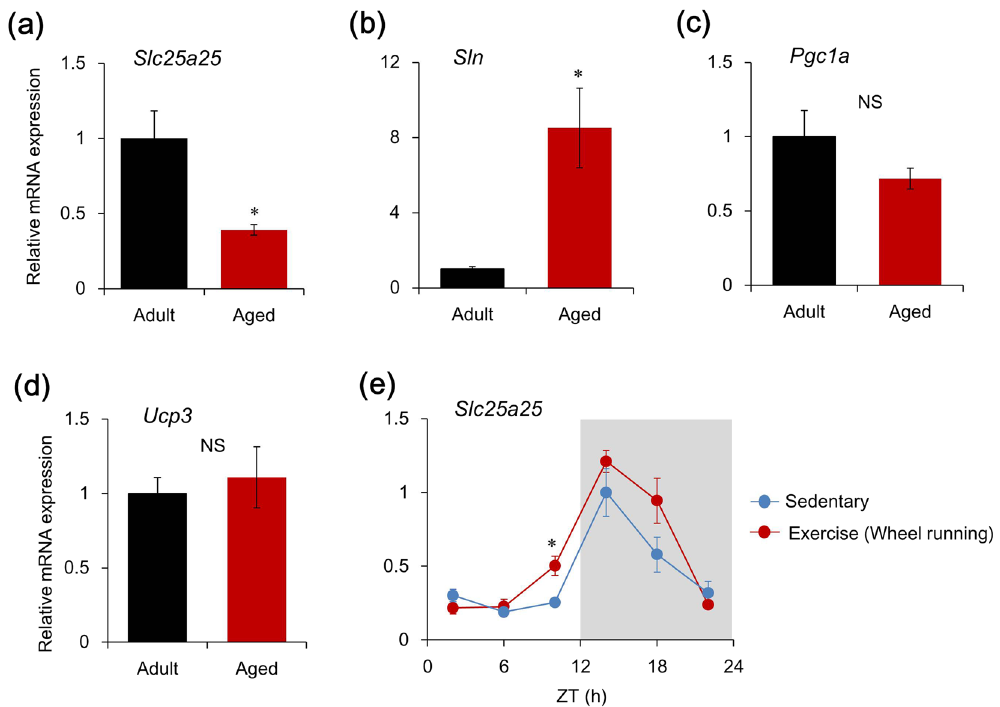
Figure 6. Aging gene-dependently affects thermogenic gene expression. ( a – d ) Messenger RNA expression of thermogenic gene in skeletal muscles of adult and aged mice (aged 7–8 and 23–24 months, respectively). Data are expressed as means ± SEM (n = 6–10 per group). Maximal value for adult mice is expressed as 1.0. * P < 0.05 for adult vs. aged mice. ( e ) Effects of voluntary running on Slc25a25 mRNA expression in skeletal muscle. Mice were individually housed in cages with or without (to mimic sedentary conditions) running-wheels for four weeks. Gray shading indicates dark period. Data are shown as means ± SEM (n = 4–5). Maximal value for sedentary mice is expressed as 1.0. * P < 0.05 for sedentary vs. running-wheel. Supplemental Tables 7 and 8 show results of statistical